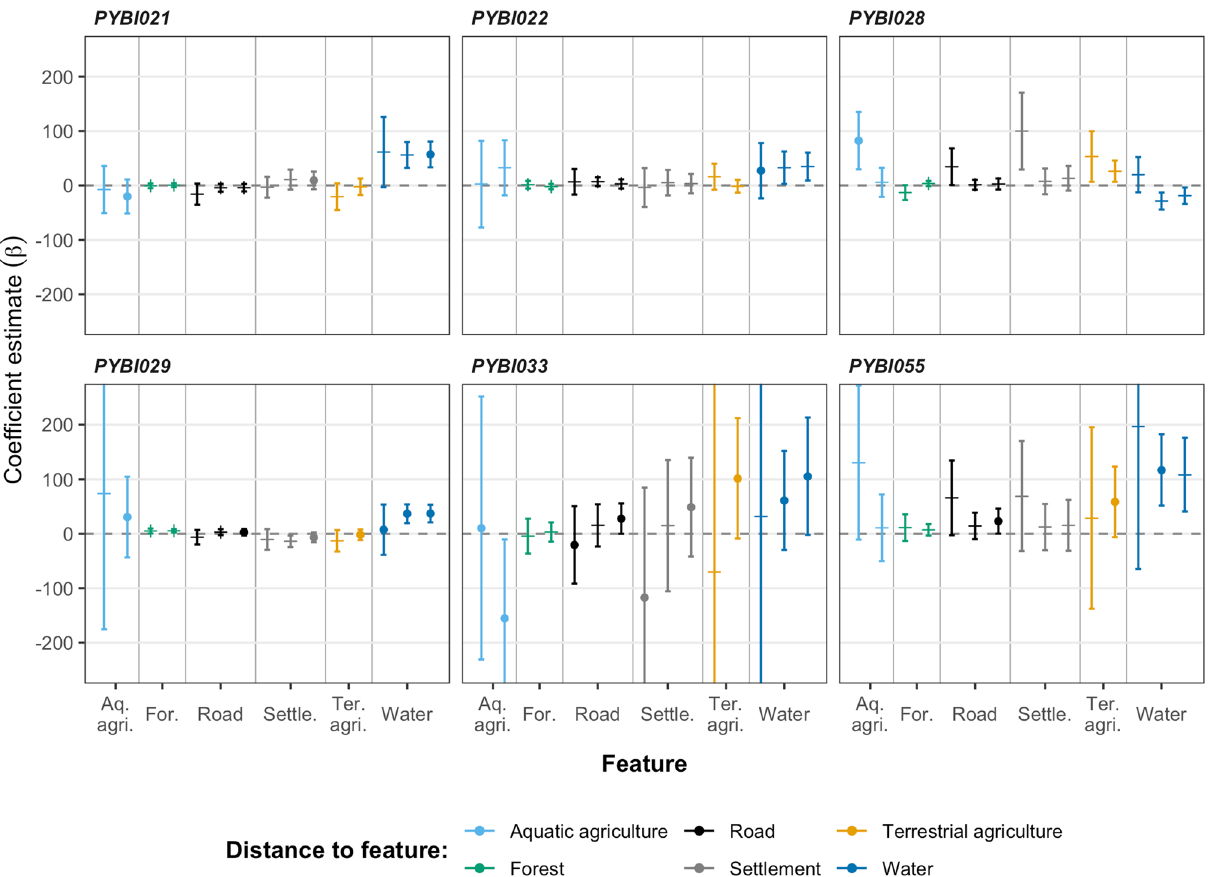
Figure 5. All coefficients from individual integrated step selection functions for Burmese pythons ( Python bivittatus ) tracked in the agricultural matrix (i.e., all individuals excluding PYBI060) within the Sakaerat Biosphere Reserve, Nakhon Ratchasima. Positive estimates suggest association with habitat feature. Error bars indicate 95% confidence intervals. Circles mark the habitat features that were included in models with the lowest AIC